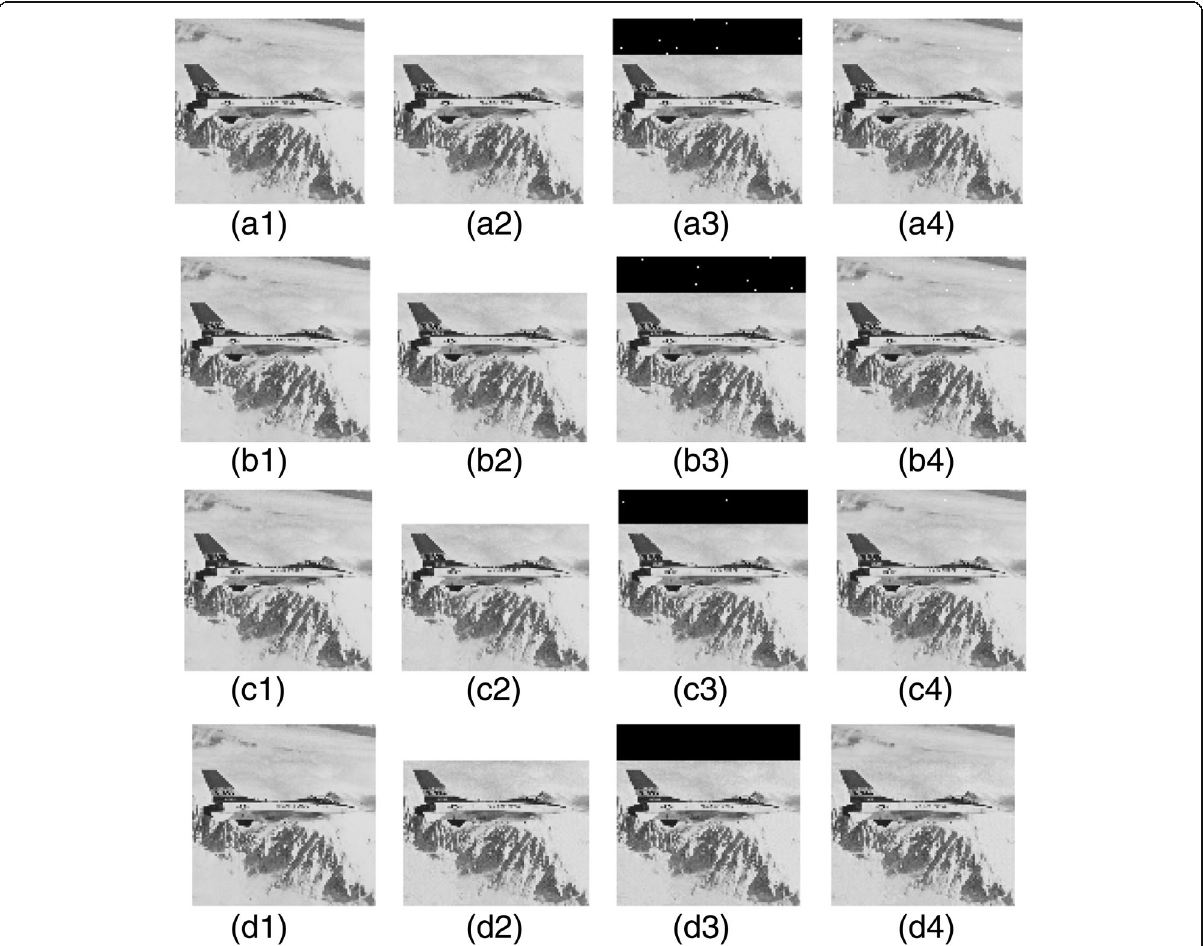
Fig. 18 Example of the 20% tampered Airplane image with cropped image of four schemes. (a1 – a4) Scheme [1]; (b1 – b4) scheme [7]; (c1 – c4) scheme [24]; (d1 – d4) scheme [48]. First column: Airplane original images, second column: tampered images, third column: tamper detection, fourth column: tamper